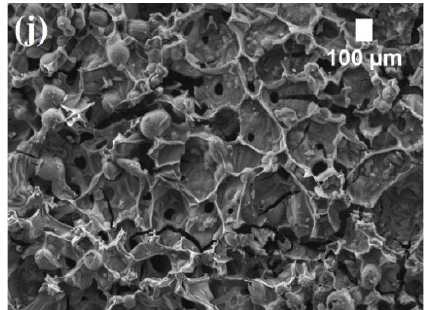
Figure 6. SEM images of char residues after the cone calorimeter test (magnification × 50): ( a ) SFP-0; ( b ) SFP-10; ( c ) SFP-30; ( d ) SFP-10/LG; ( e ) SFP-30/LG; ( f ) SFP-0/TCPP; ( g ) SFP-10/TCPP; ( h ) SFP-30/TCPP; ( i ) SFP-10/LG/TCPP; and ( j ) SFP-30/LG/TCPP.